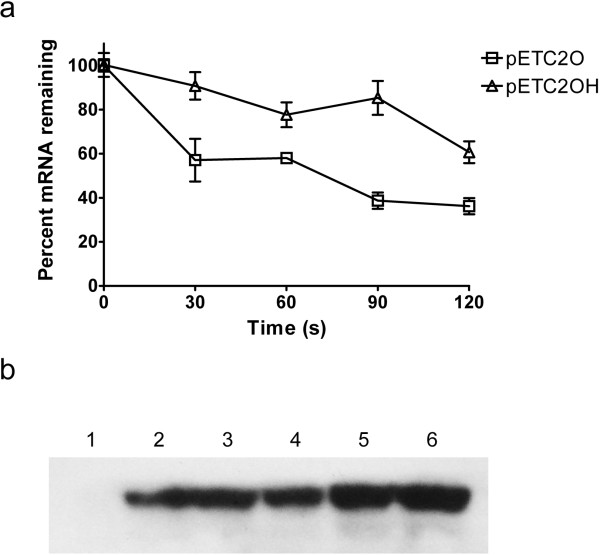
 Gene expression profiles and western blot analysis of PhaC2Pss in recombinantE. coliharboring pET-based plasmids. (a) The decay profiles of the transcripts of phaC2PsO and phaC2PsOH determined by quantitative RT-PCR. After adding rifampicin and incubating for 1 min, samples were iced at different timed intervals. The relevant abundances of mRNA compared to the ompA mRNA abundance were determined by qPCR, and the y axis showed the percentages of the remaining mRNA at timed intervals. Experiments were carried out in triplicate. (b) Western blot analysis of the PHA synthase PhaC2Ps expressed in recombinant E. coli harboring pET-based plasmids. Lane 1 to 6: crude extracts from recombinant E. coli harboring pET28a, pETC2, pETC2QK, pETC2QKST, pETC2O, and pETC2OH, respectively.